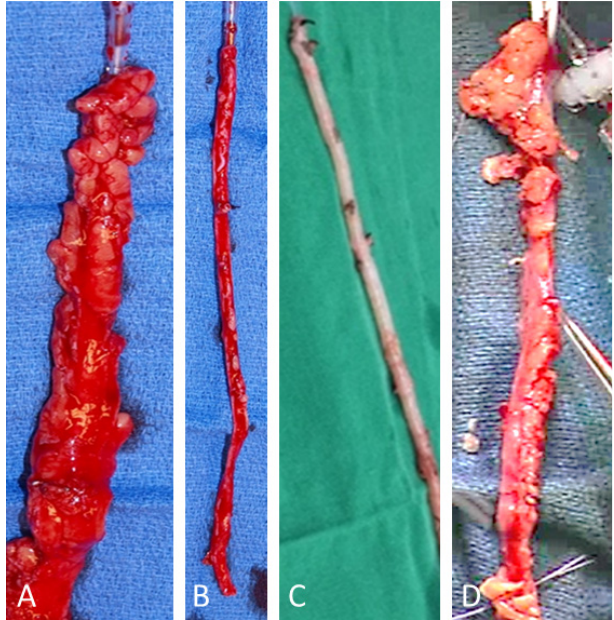
Fig. 1 - Comparison of saphenous veins harvested for coronary artery bypass grafting. Examples of saphenous vein explants at harvesting: A) No-touch, B) conventional, C) endoscopic, and D) no-touch endoscopic. (From Yoshino et al. [61] ,